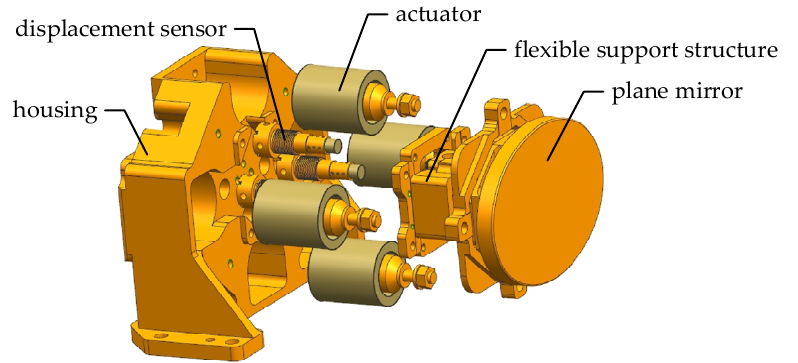
Figure 6. Structure composition of two-axis FSM.